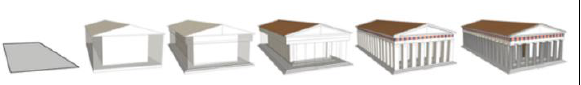
Figure 10. Example of 3D model created using CGA rules